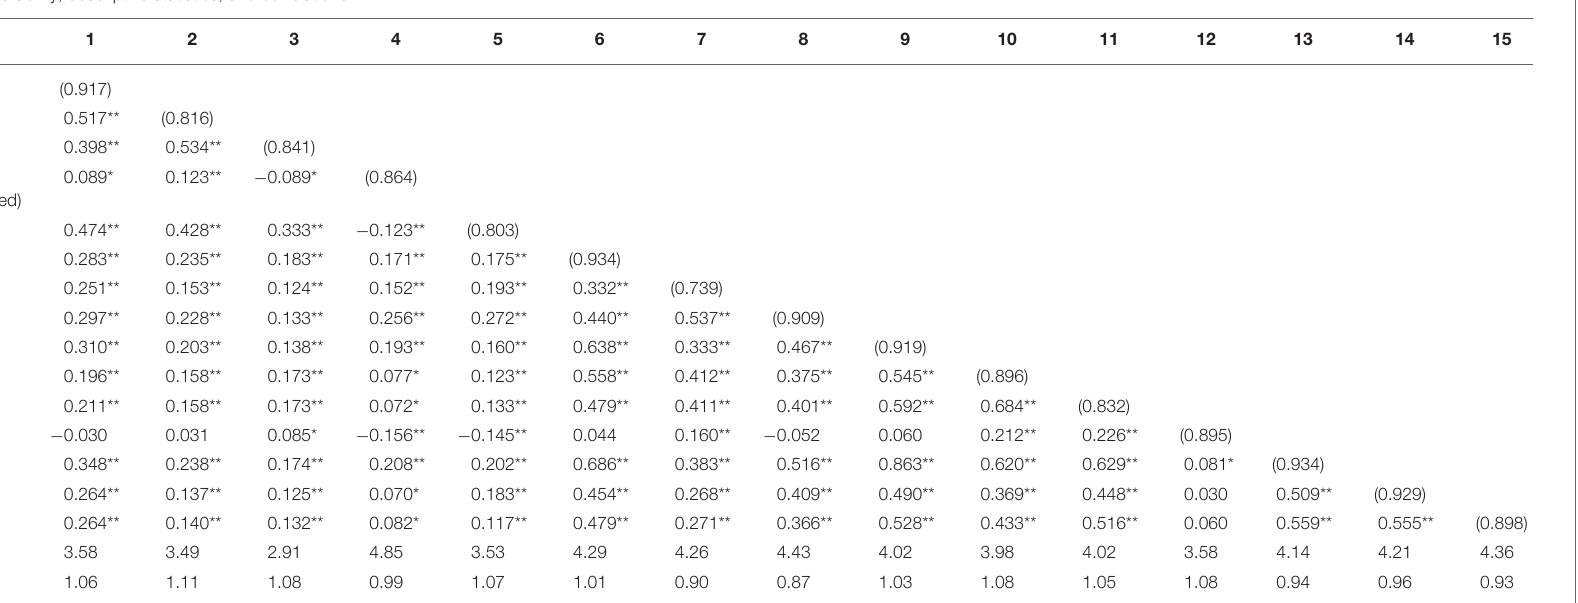
TABLE 3 | Reliability, descriptive statistics, and